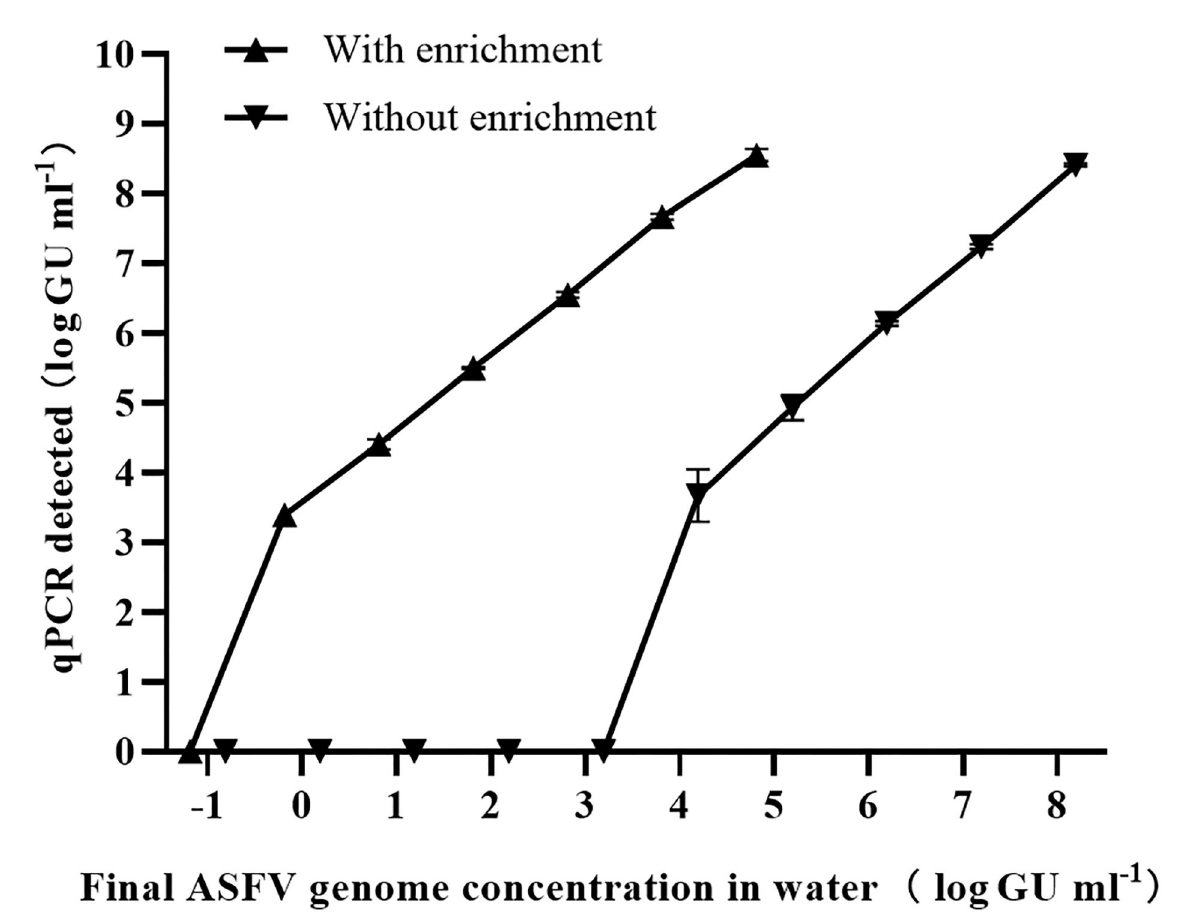
FIGURE4 Eighteen barrels of spiked water with six final concentrations of ASFV (10L per barrel) were enriched using the MDEF system, and the presence of the ASFV genome in both spiked water (without enrichment) and eluates (with enrichment) was measured by qPCR. The LODs were determined for both conditions with the LOD of the 10-L ASFV-contaminated increasing 1 × 10 4.0 times (from 1 × 10 3.67 ± 0.27 GU ml − 1 to 1 × 10 − 0.33 ± 0.27 GU ml − 1 ) after